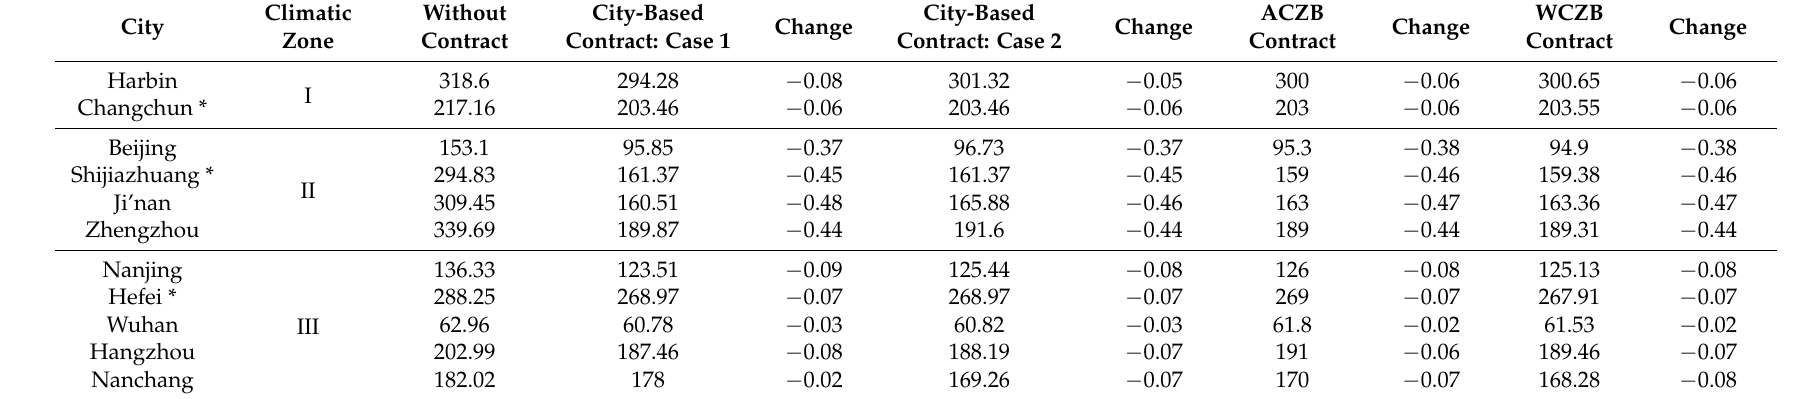
Table 5. Efficiency comparison among city-based GDD contracts, ACZB contracts and WCZB contracts: mean root square loss (MRSL). Climatic Without City-Based City Zone Contract Contract: Case 1